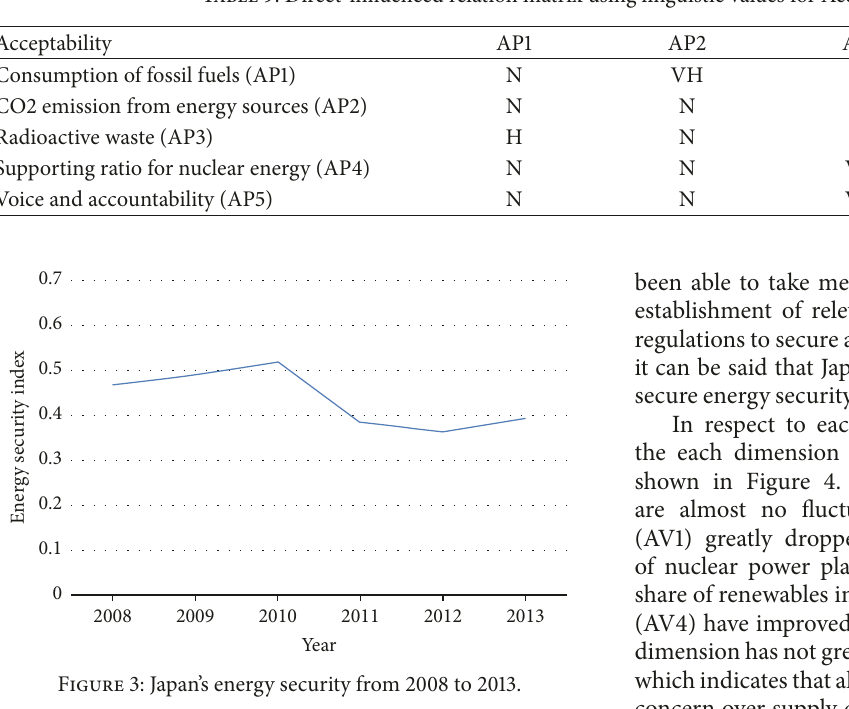
Table 9: Direct-influenced relation matrix using linguistic values for Acceptability (Case 2 ).